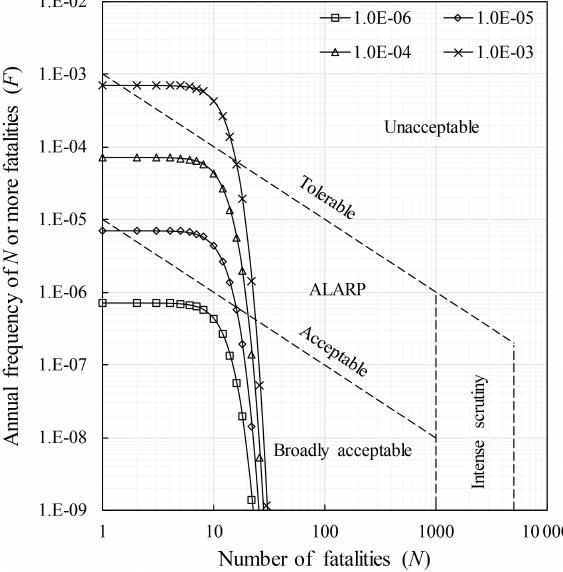
Figure 13. Impact of the annual failure probability of the slope on the annual societal risk.